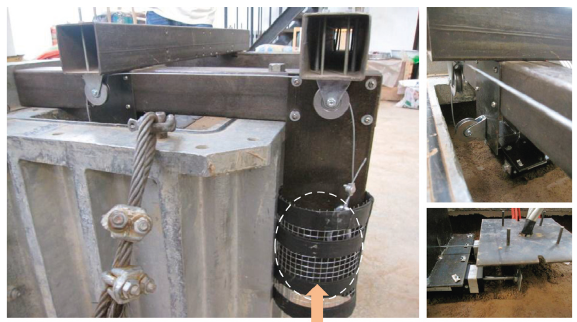
Figure 9: Horizontal loading